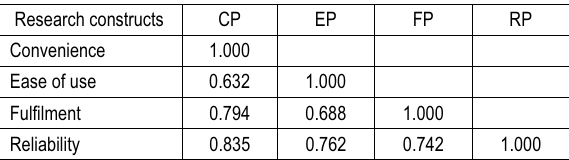
Table 2. Correlation matrix between research